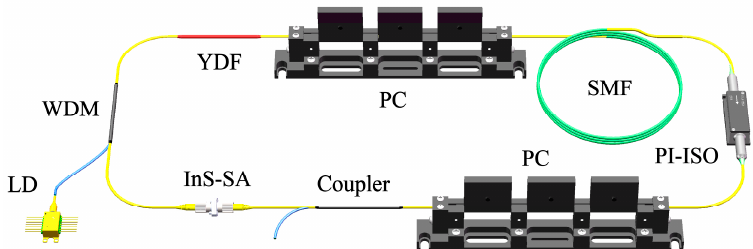
Figure 3. Experimental setup of the mode-locked Yb-doped fiber pulse laser. LD: laser diode; YDF: